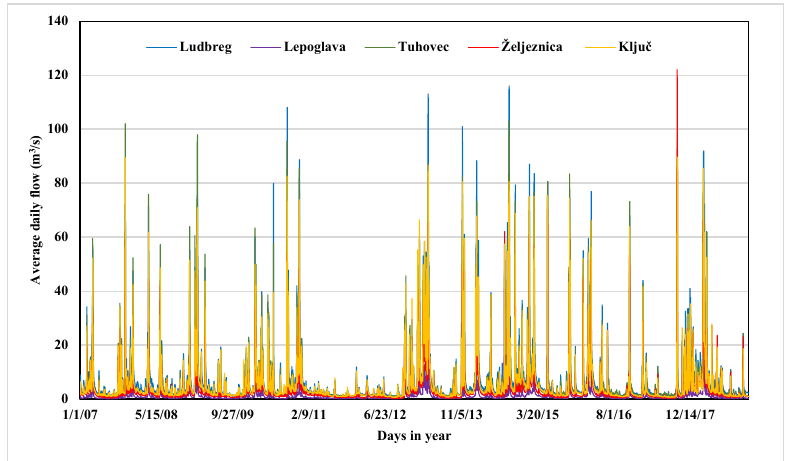
Figure 3. Comparison of the average daily flow of River Bednja on all five measurement stations. Table 3. Streamflow rate statistics were computed for the measurement